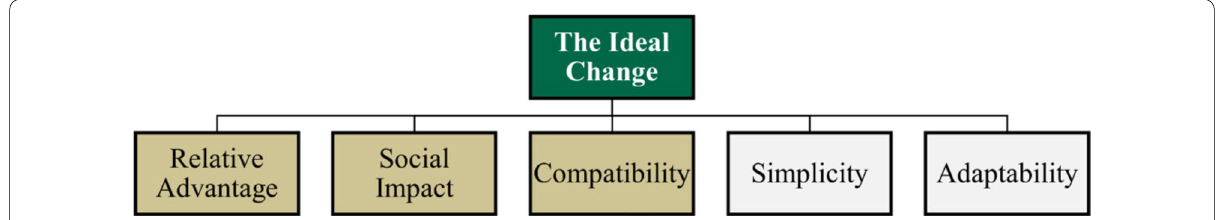
Fig. 1 Components of ideal change according to the CACAO model. The CAFI explicitly explores Relative Advantage, Social Impact, and Compatibility, while Simplicity and Adaptability are not considered in order to improve utility for a variety of potential instructional